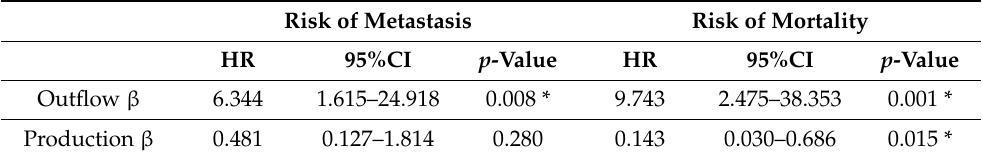
Table 3. Risk of metastatic uveal melanoma and mortality. The baseline for the Cox proportional hazard model included those using medication with an effect on the outflow of aqueous humor and controls from 2000 onwards. For the medication group with an effect on the production of aqueous humor, the baseline was set to 1994. Presented as hazard ratio with corresponding 95% confidence interval and p